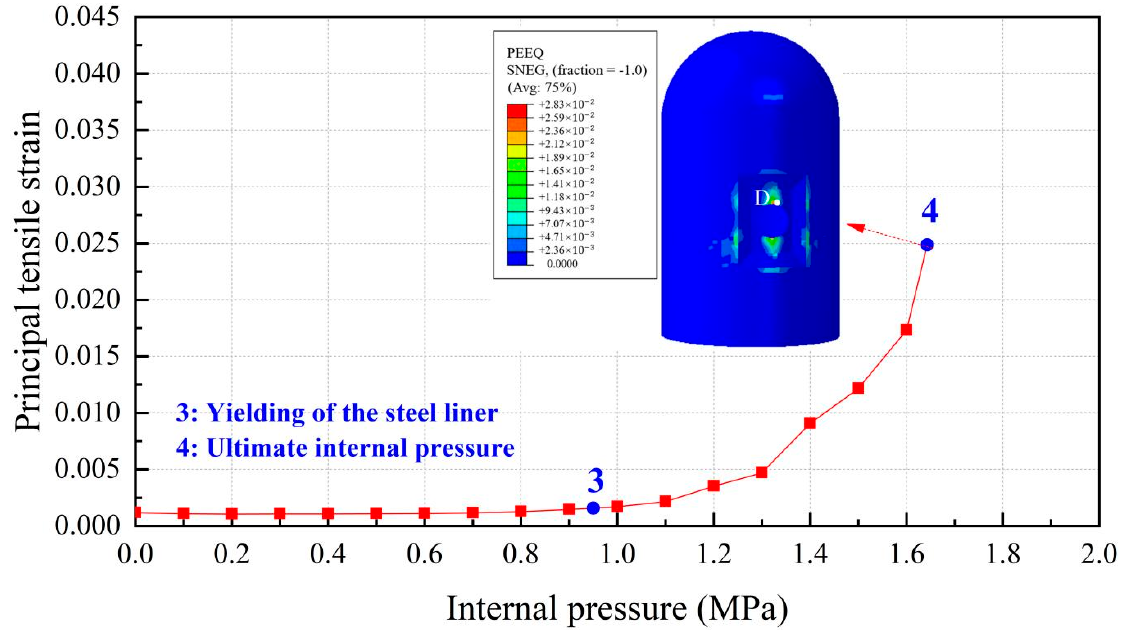
Figure 9. Principal tensile strain of the steel liner (Note: point D is at the apex of the hole and the red squares represent the principal tensile strain of steel liner).